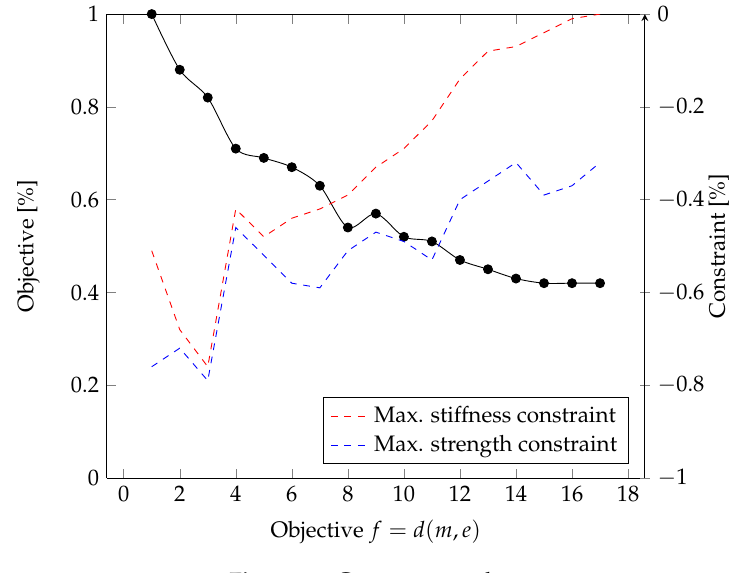
Figure 13. Convergence plot.